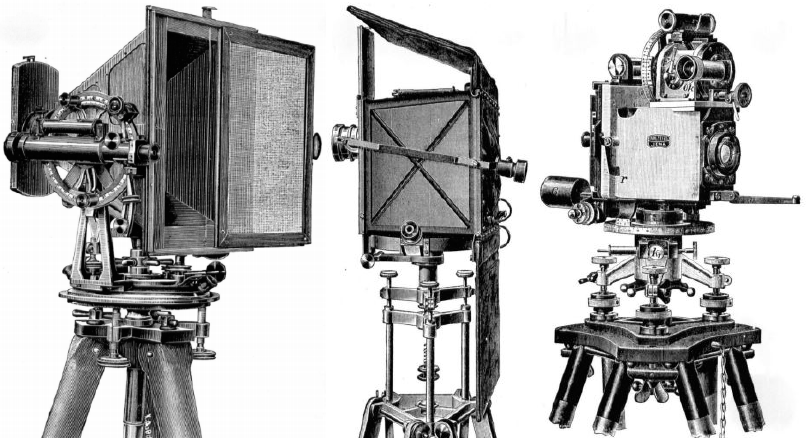
Figure 2. Photo theodolite from Italian army ( left ), Finsterwalder photo theodolite ( middle ), and Pulfrich photo theodolite ( right ) [18].